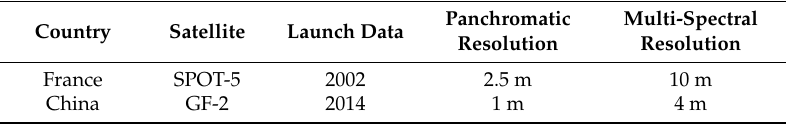
Table 2. SPOT 5 and GF-2 satellite data information.